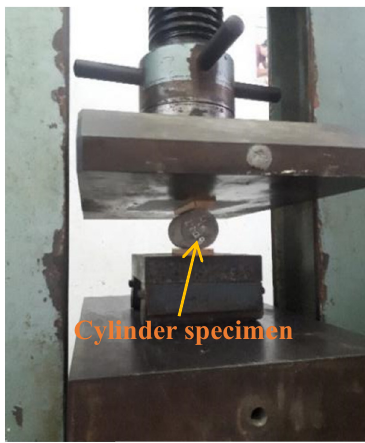
Figure 6: Splitting tensile test.